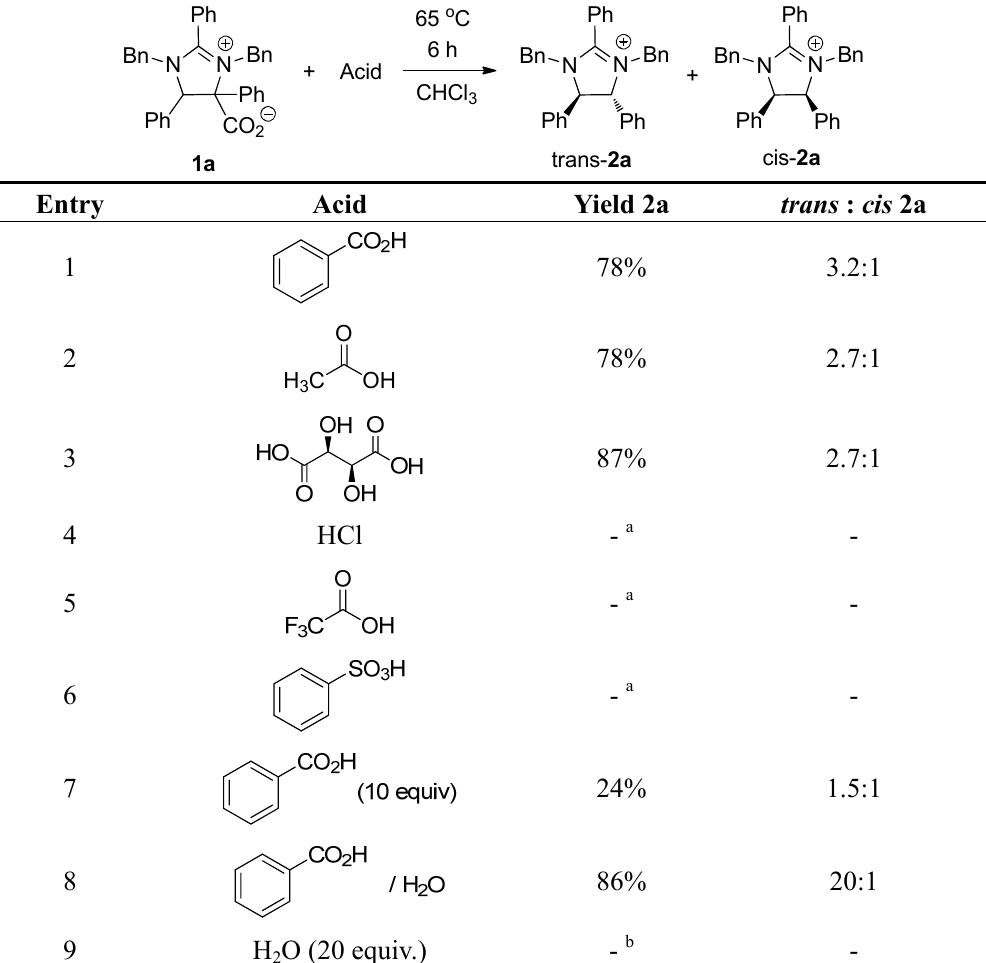
Table 1. Influence of acids on the generation of imidazolinium